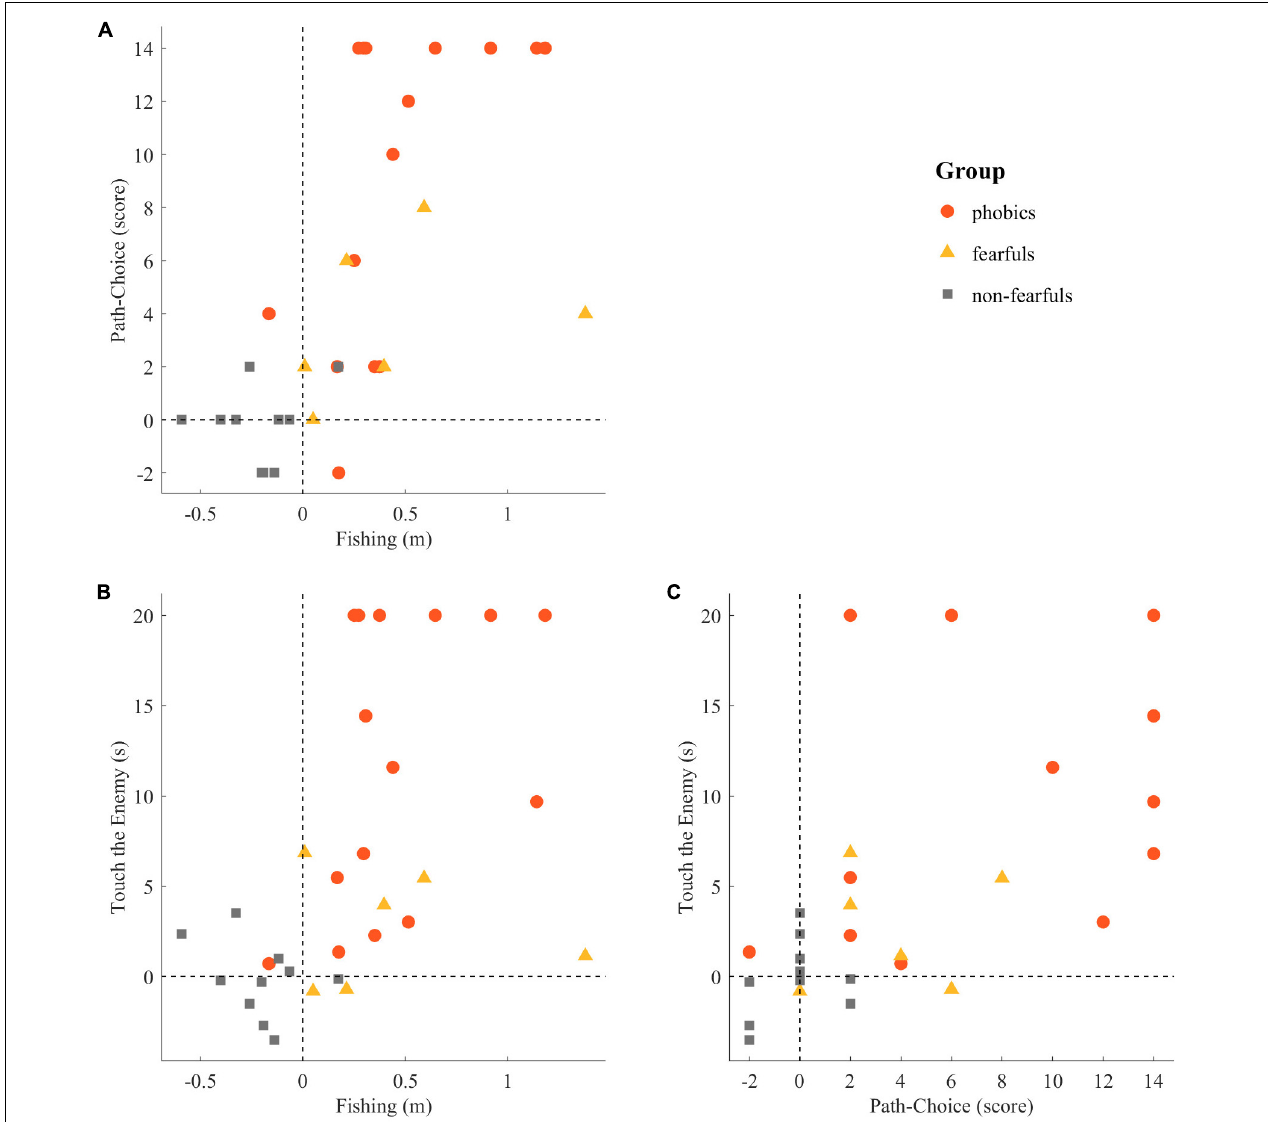
FIGURE 11 | Consistency of behavioral tasks: (A) Fishing vs. Path-Choice, (B) Fishing vs. Touch the Enemy, and (C) Path-Choice vs. Touch the Enemy. Individual values in the Touch the Enemy task were truncated to 20 s. Points represent individual readouts, and dashed lines indicate the boundary between avoidance and approach behavior in each